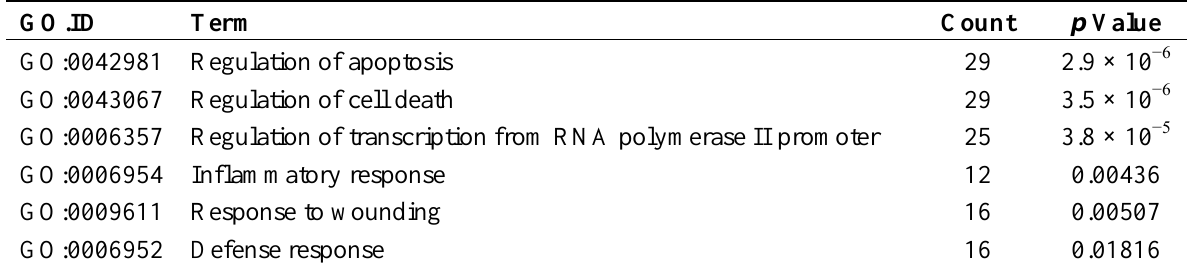
Table 3. GO terms of biological process significantly affected by SM30 NPs in A549 cells. Count = number of differentially expressed genes identified within each category.